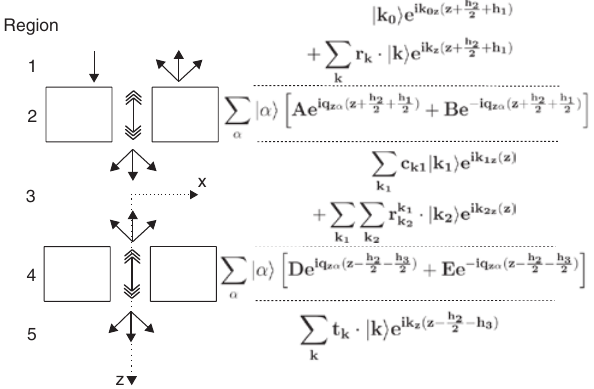
Figure 2: Field definition for each region of the structure.